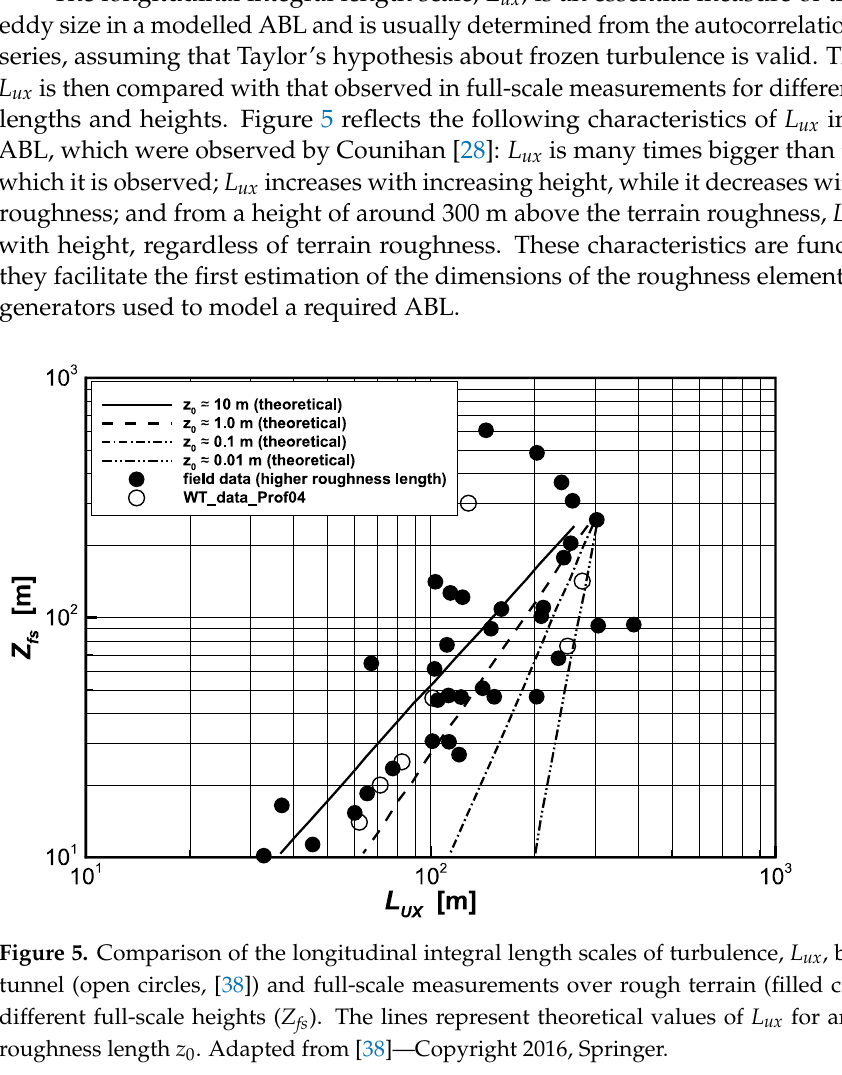
Table 1. Roughness lengths ( z 0 ), profile exponents ( α ), and zero plane displacements ( d 0 ), according to [32]. Roughness Class